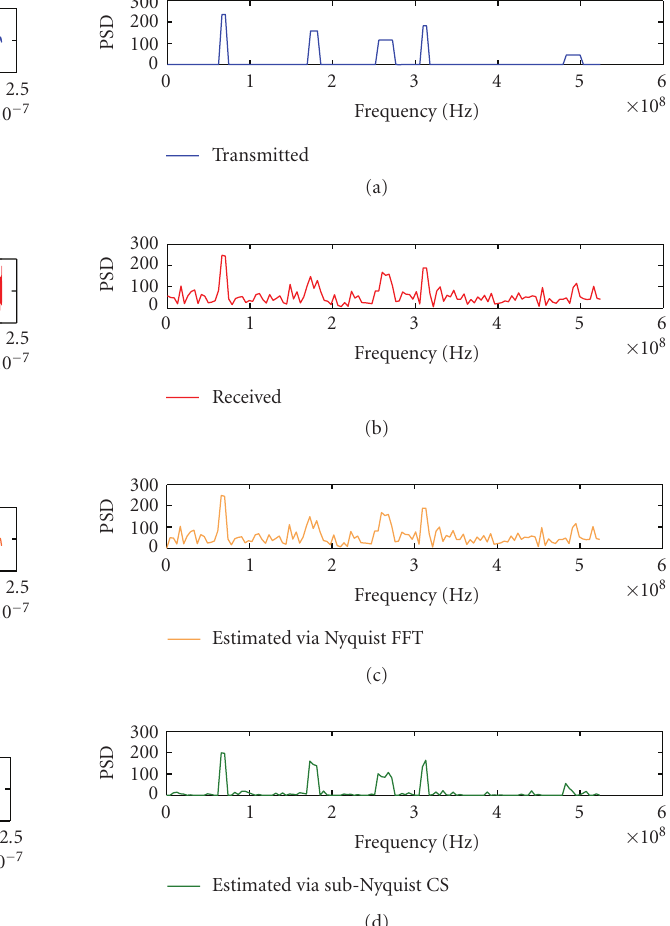
Figure 5: Frequency-domain signals of a simulated multiband signal. From top to bottom, the four plots represent the transmitted signal by primary users, the received primary users’ signal at the sensing radio, the reconstructed signal from the time-domain samples via the Nyquist rate ADC, and the reconstructed signal from the transform-domain samples via mixed-CS at a NSR of 0 .